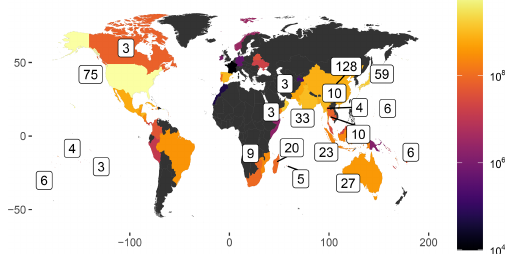
Figure 17. Number of tropical cyclones with reported damage cost in the EM-DAT database. The color scale indicates the average re- ported damage cost in USD in each country for each tropical cy- clone.